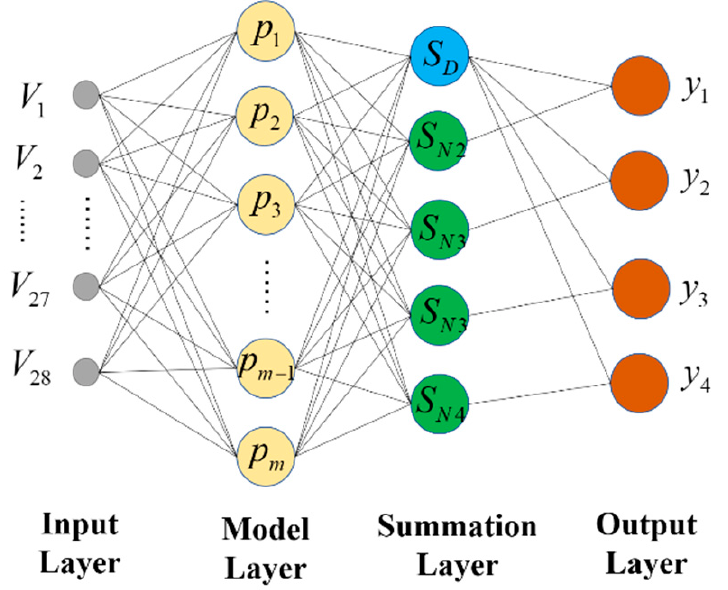
P , S and S are node m D N